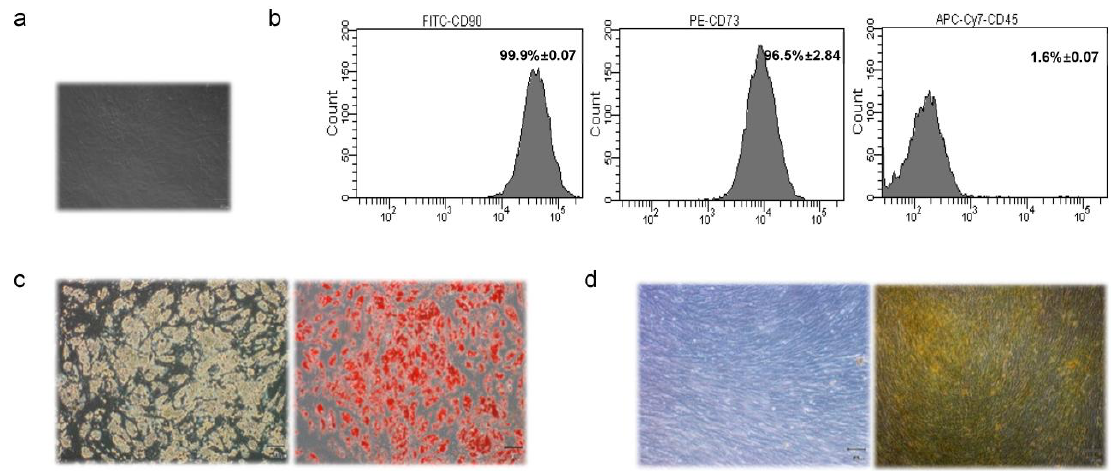
Figure 1. Characterization of MSCs isolated from Mammary Adipose Tissue (MAT-MSCs) . ( a ) Representative microscopic image (magnification 10X) of MAT-MSCs. ( b ) Representative dot plots from FACS analysis of MAT-MSCs stained for FITC-anti-CD90, PE-anti-CD73, APC-Cy7-anti-CD45 antigens. ( c ) Representative microscopic images (magnification 10×) of MAT-MSCs differentiated towards the adipogenic lineage, stained (right) and not (left) with oil red O for lipid accumulation detection. ( d ) Representative microscopic images (magnification 10×) of MAT-MSCs differentiated towards osteogenic lineage, stained (right) and not (left) with alizarin red S for calcium accumulation detection.